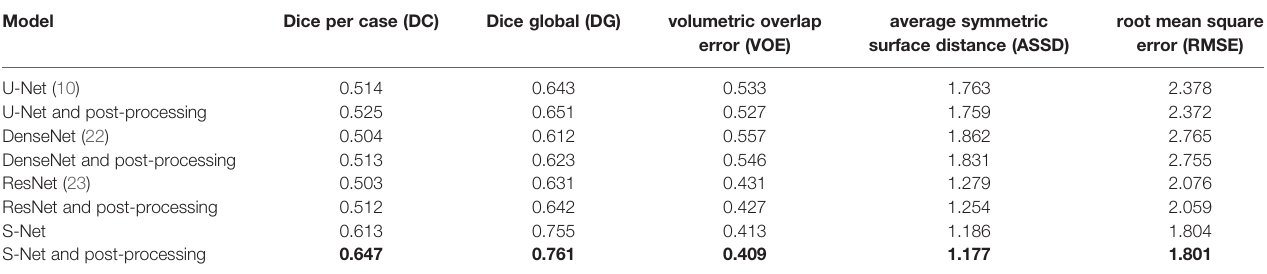
TABLE 1 | Liver tumor segmentation results by S-Net, and U-Net, DenseNet and ResNet.